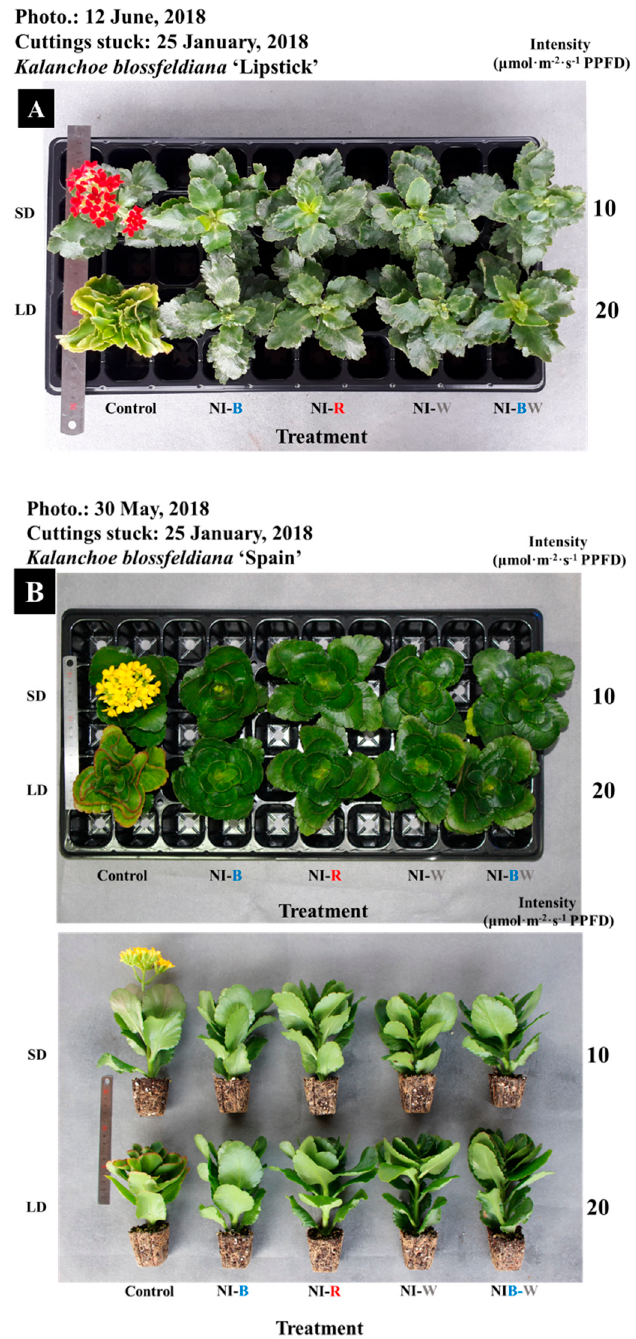
Figure 5. The effects of the night interruption light (NIL) quality at 10 or 20 µ mol · m − 2 · s − 1 PPFD on the flowering of kalanchoe ( Kalanchoe blossfeldiana ) ‘Lipstick’ ( A ) and ‘Spain’ ( B ) measured 98 and 71 days after treatment initiation, respectively. Please refer to Figure 1 for details on the NIL quality.